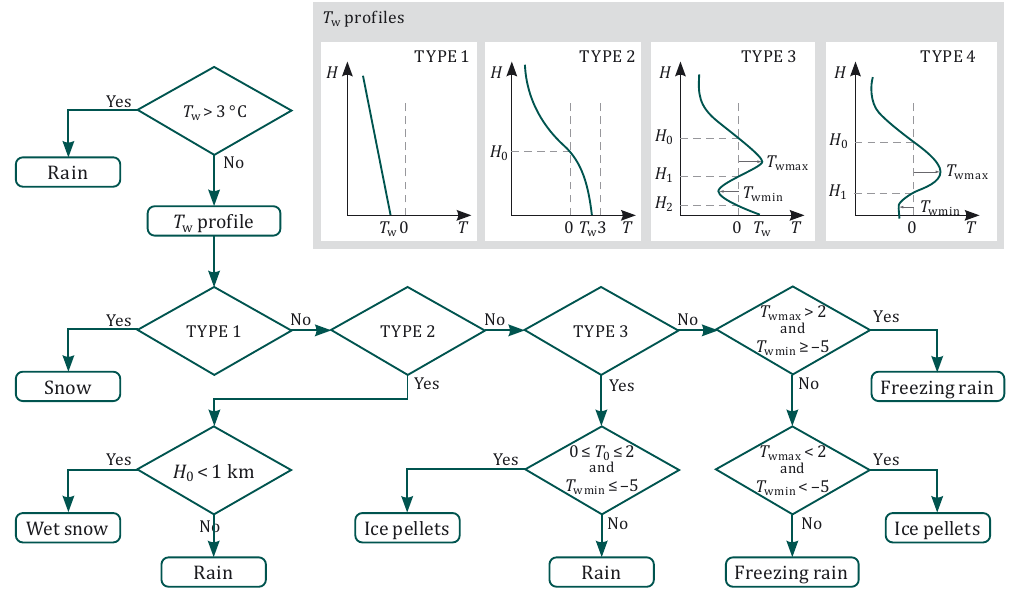
Figure 3. Prediction of freezing rain using Ramer